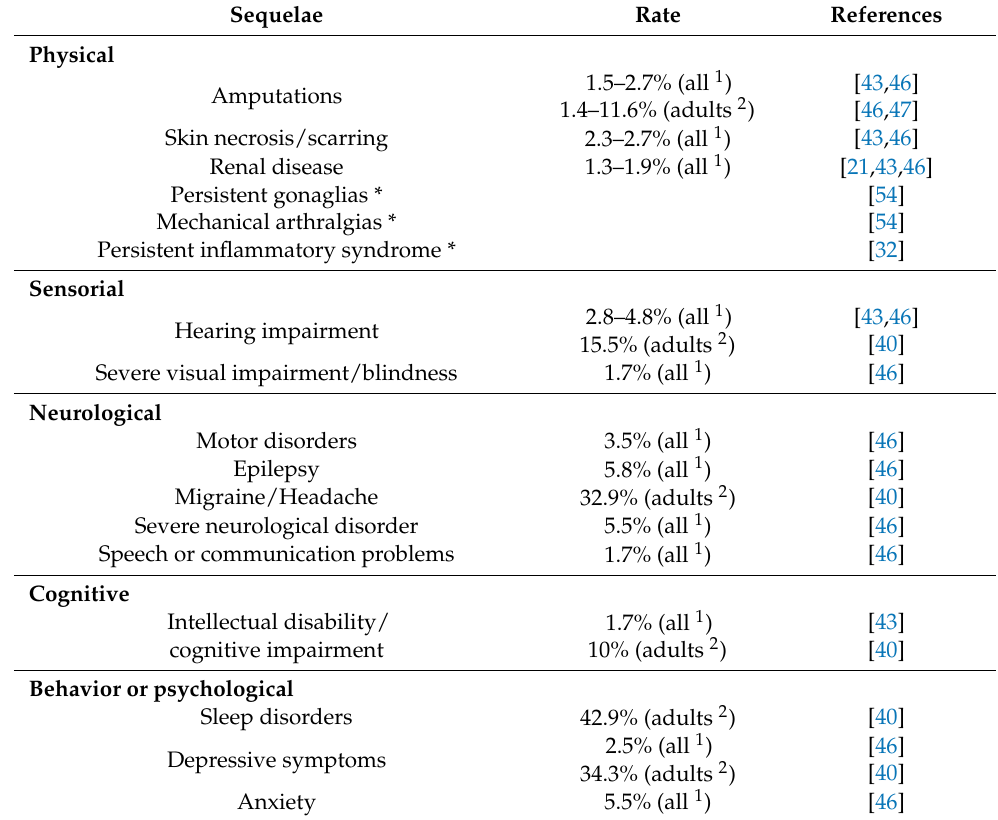
Table 4. Type of sequelae associated with invasive meningococcal